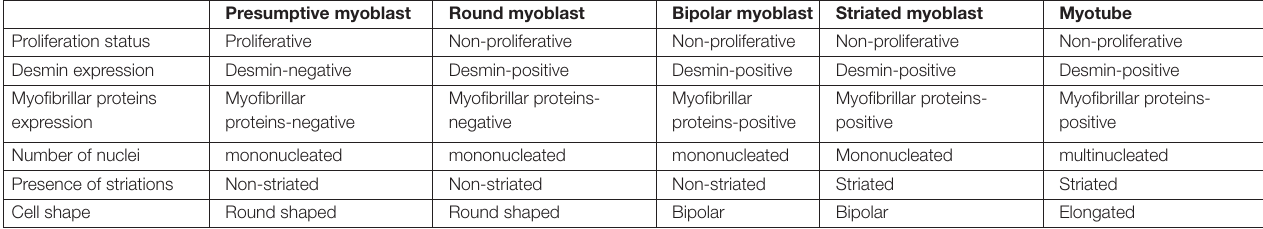
TABLE 1 | Characteristics of specific cell phenotypes during chick skeletal myogenesis.